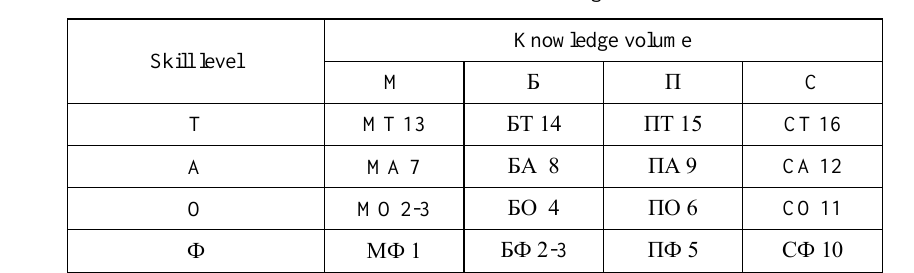
Table 1. Formation of the training